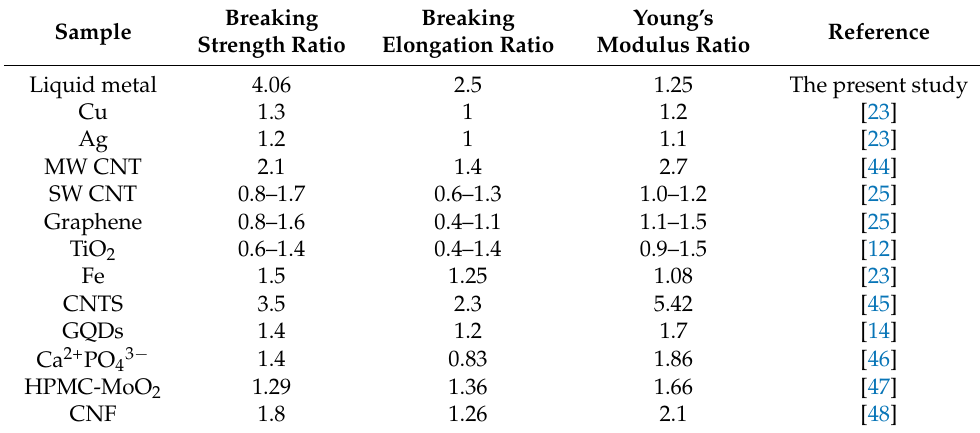
Table 1. Summary of the mechanical property control-relative ratios of the silk fibers modified with different materials.